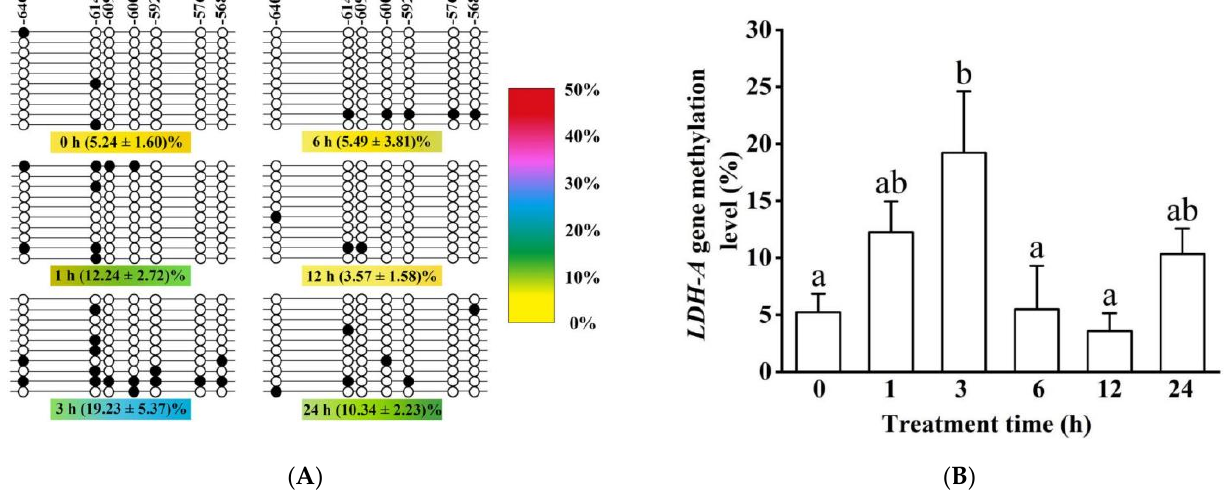
Figure 12. DNA methylation status of the LDH-A gene. ( A ) The DNA methylation status of the LDH-A gene. The legend is similar to Figure 11A. ( B ) The methylation level of the LDH-A gene in different hypoxia groups. Different letters indicate significant differences ( p < 0.05).